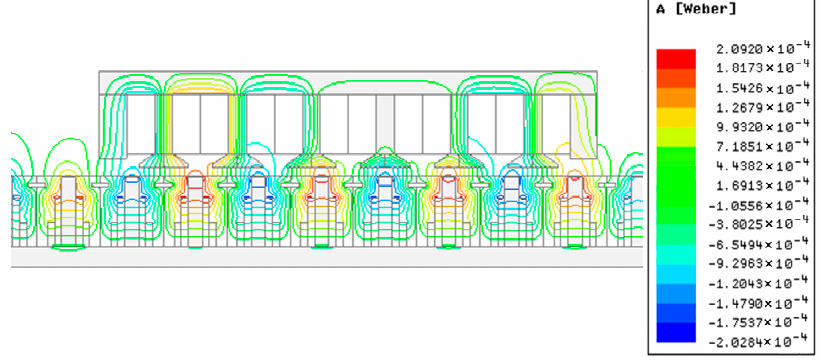
Figure 4. The magnetic distribution of MI-TLPMG on the no-load condition.